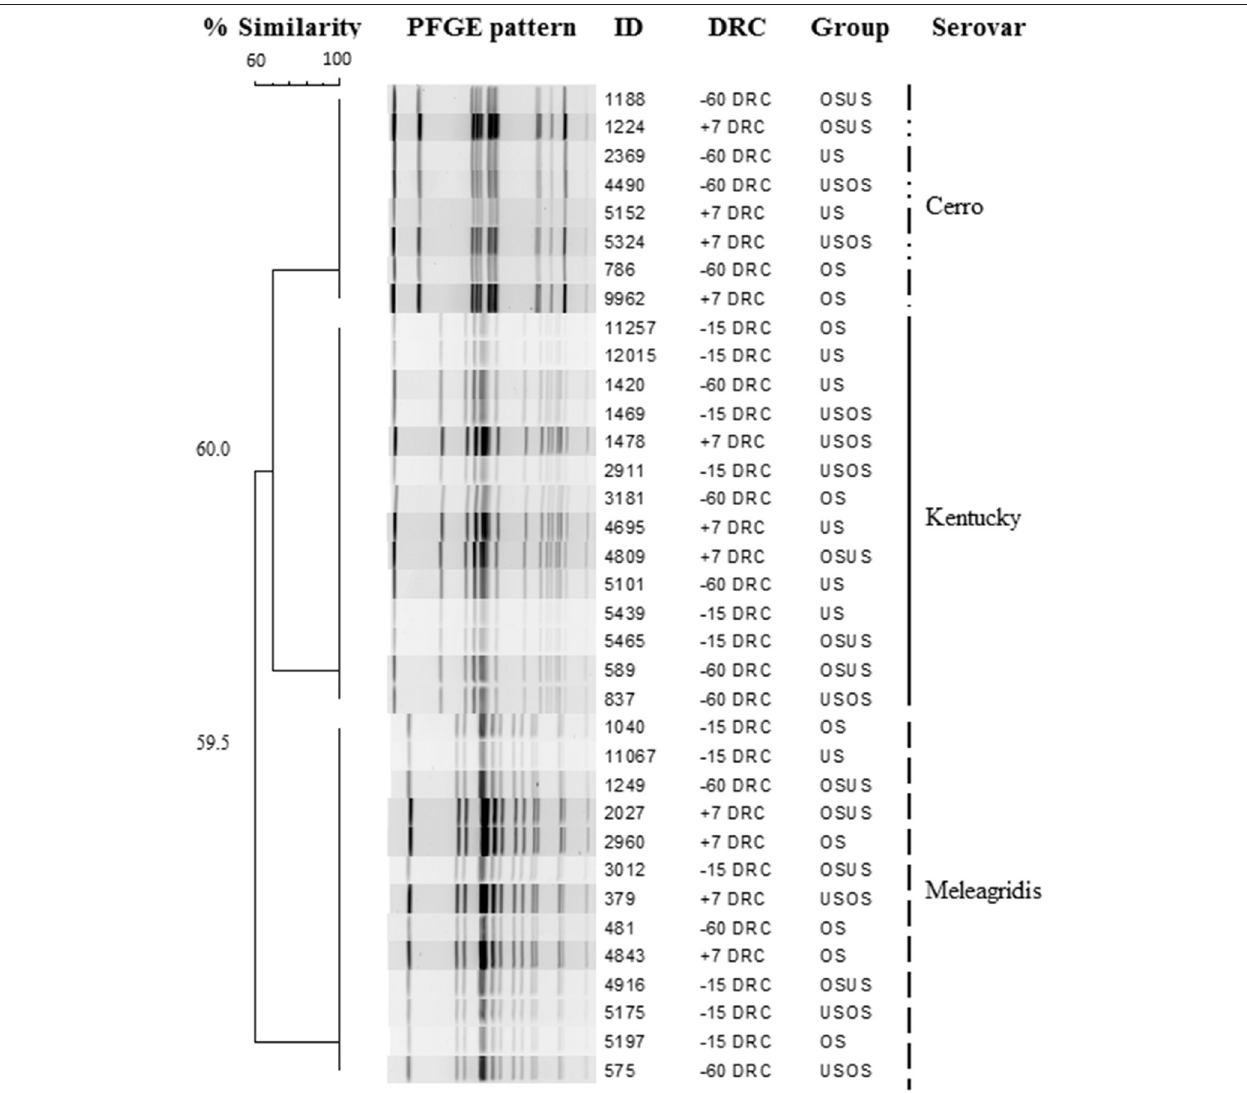
Table 3 , significant differences in NEFA concentrations between Salmonella positive and negative samples were observed after calving ( p <